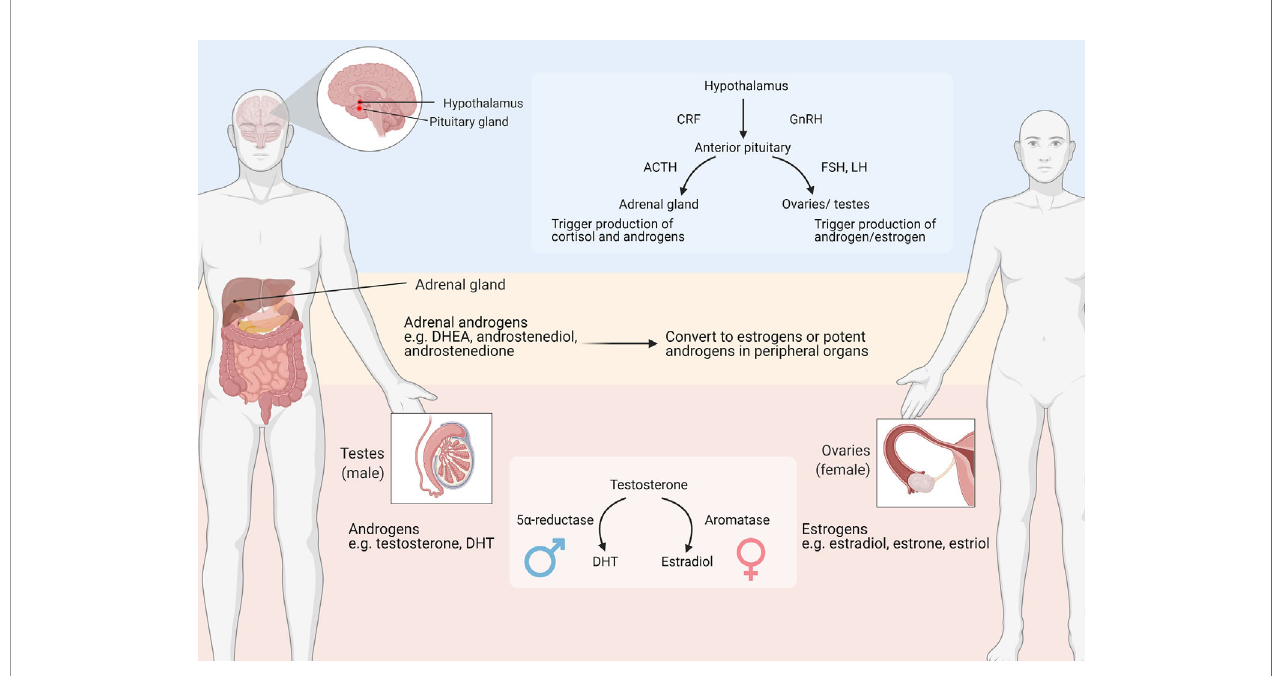
FIGURE 2 | Major organs involved in sex steroids production. ACTH: adrenocorticotropic hormone; CRF: corticotropin-releasing factor; DHEA, dehydroepiandrosterone; DHT, Dihydrotestosterone; FSH, Follicle-stimulating hormone; GnRH, Gonadotropin-releasing hormone; LH, Luteinizing hormone. Adapted from “ Primary and Secondary Endocrine Organs ” by BioRender.com (2021). Retrieved from